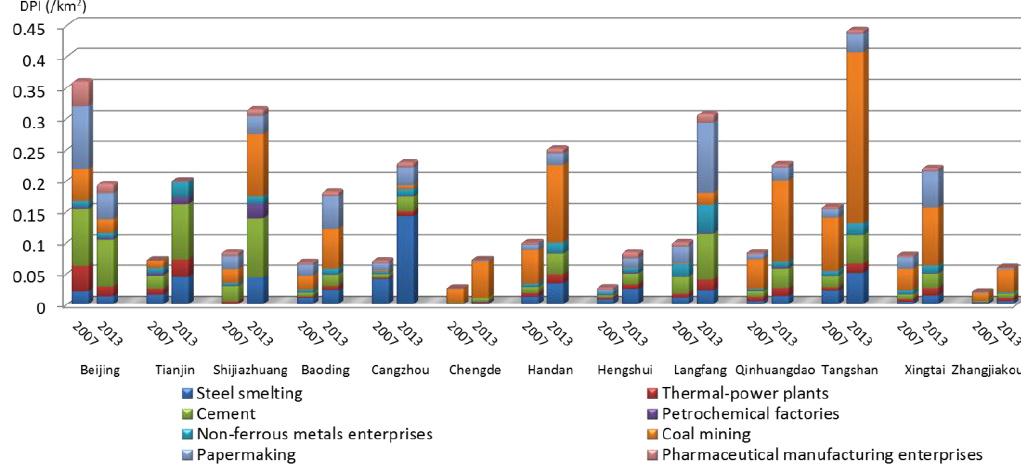
Figure 5. Statistical results of Density of Pollution Industries (DPI) according to the administrative units (municipalities) from the year of 2007 and 2013 in BTH.